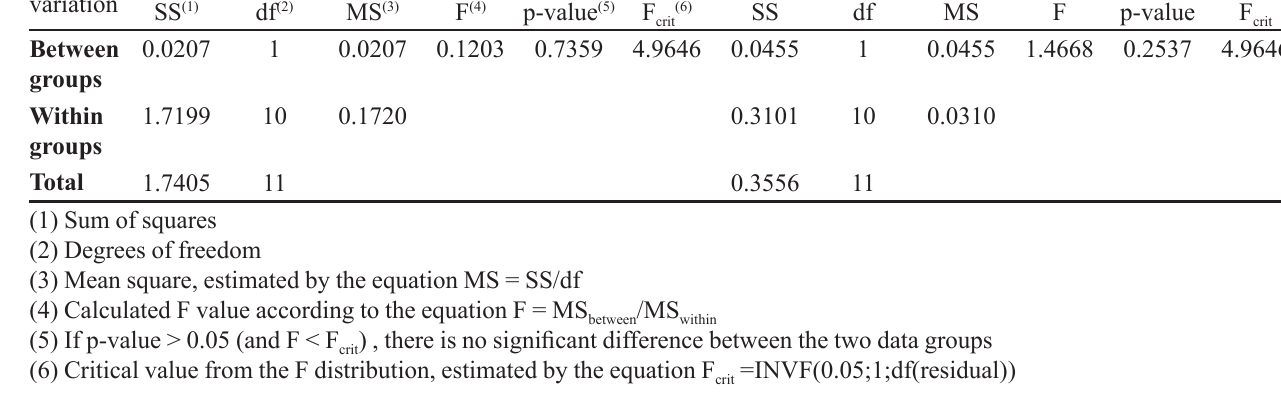
TABLE V - Single-factor analysis of variance (ANOVA) of recoveries (Table IV) for intermediate precision evaluation Source